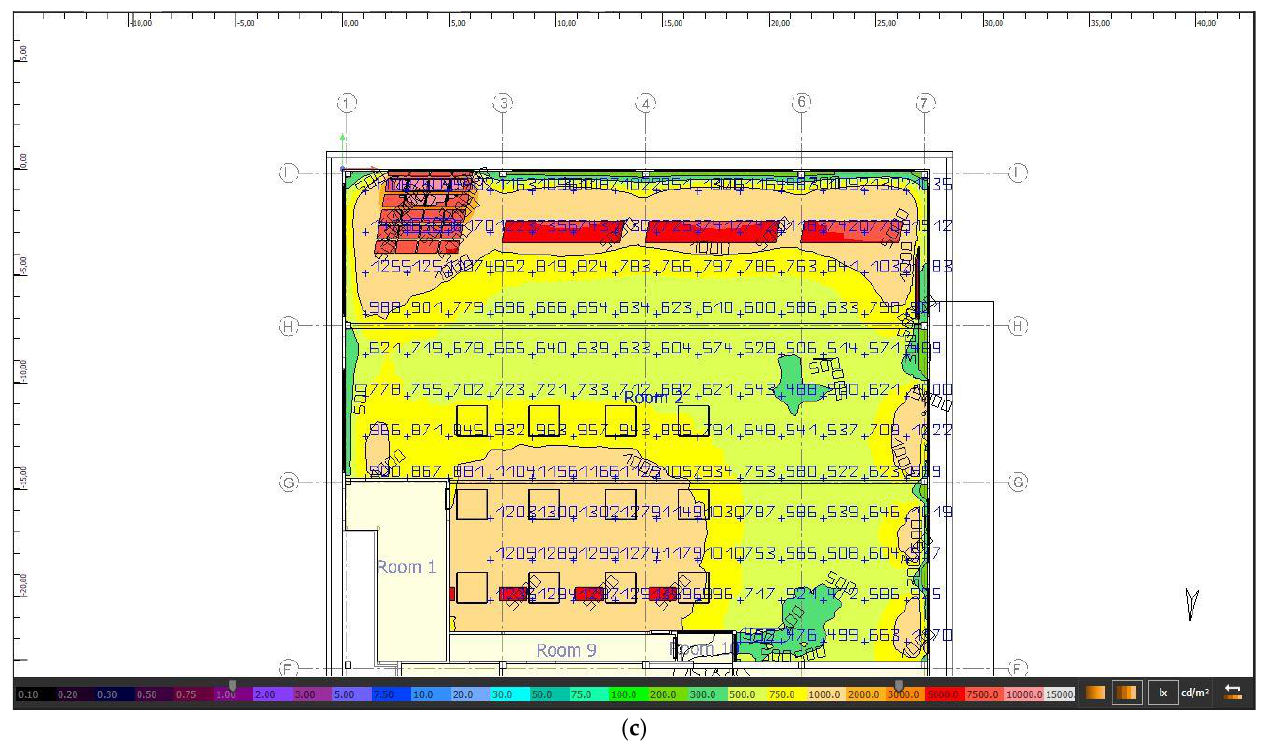
Figure 4. Design, calculation and visualisation of natural light in the service workshop: the layout of skylight domes on the floorplan of the studied object ( a ); the model of the interior of the building with selected skylights ( b ); the Luxplot resulting from twelve skylight domes of 1400 × 1400 mm dimensions at 1:00 p.m. on 22 September 2020 ( c ).